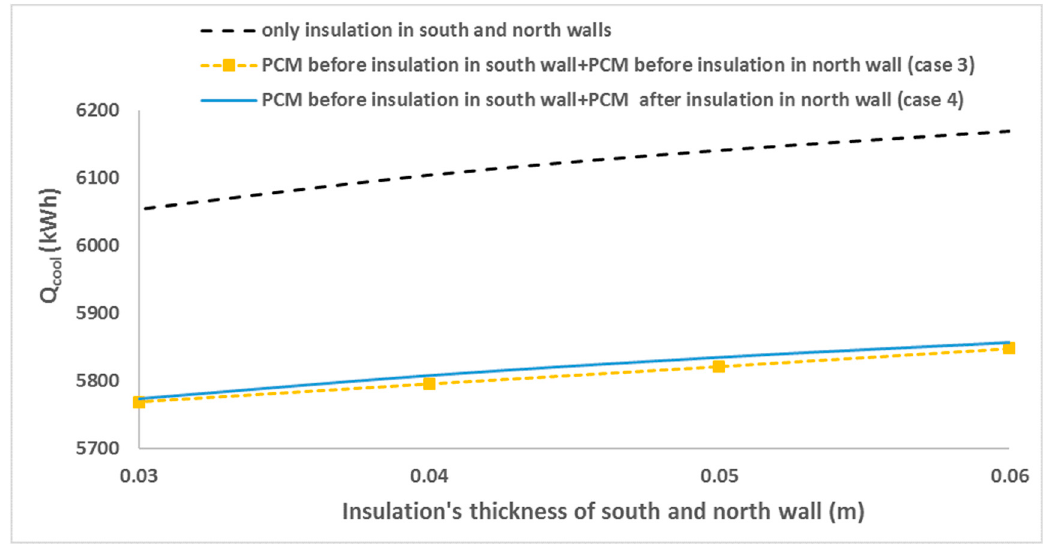
Figure 9. Annual cooling loads with PCM in two walls for different insulation scenarios.